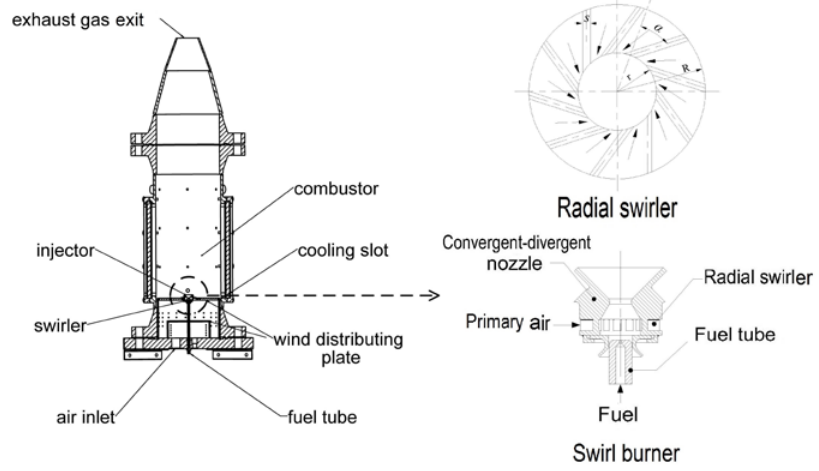
Figure 2. The combustor and swirl burner.